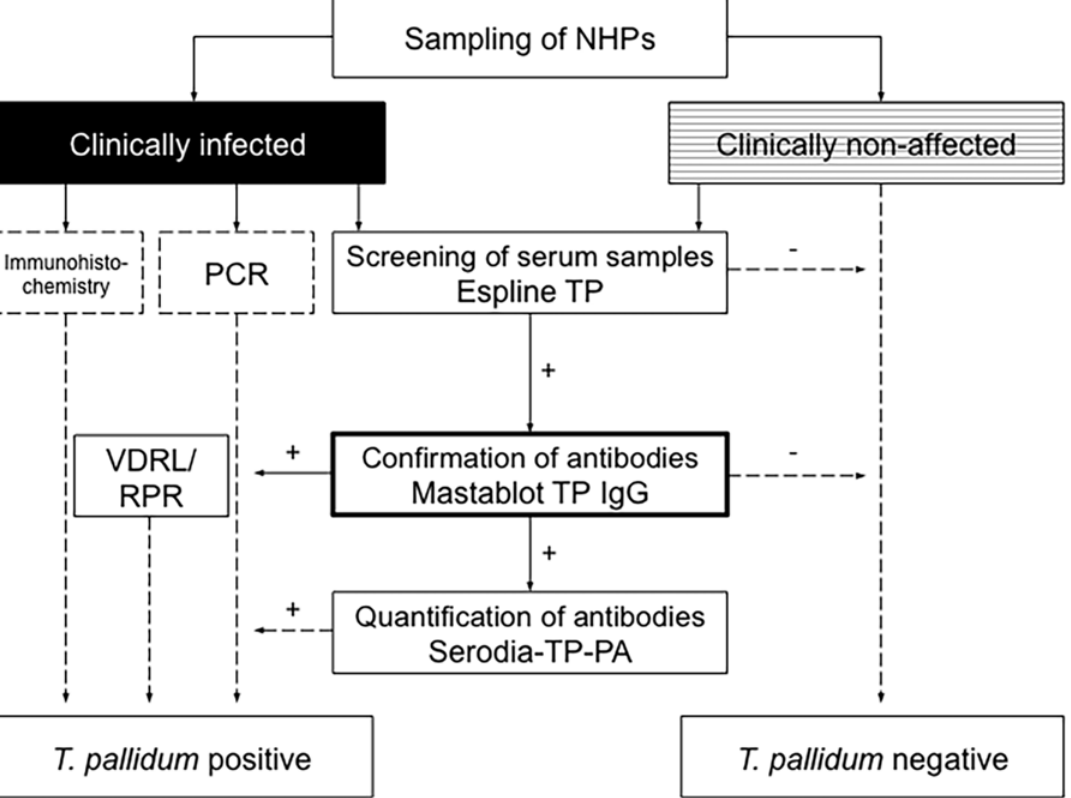
Fig 2. T . pallidum test algorithm for the screening of wild non-treated baboons. Based on the test performances Espline TP is recommended as the initial screening test followed by a confirmatory test e.g. Mastablot TP IgG that has been identified as most reliable standard. Dashed lines indicate reported results, while continuous lines represent the